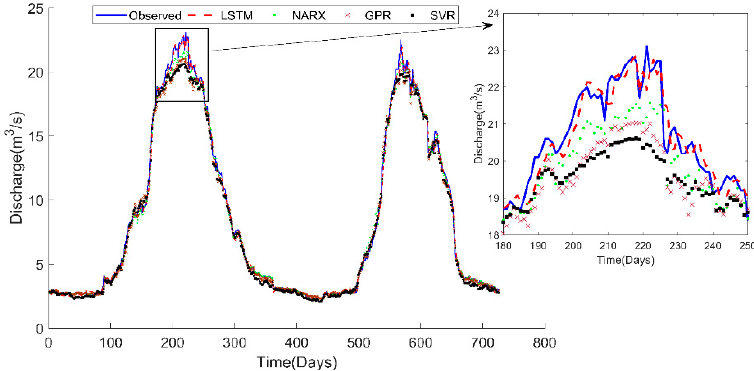
Figure 6. Comparison of observed and simulated flows.